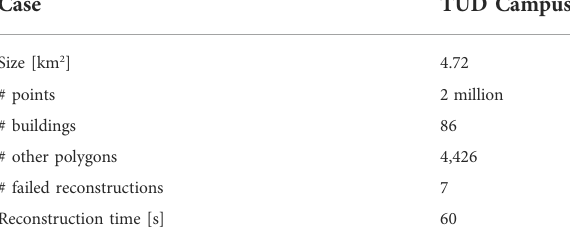
TABLE 1 Test case geometry and reconstruction information.